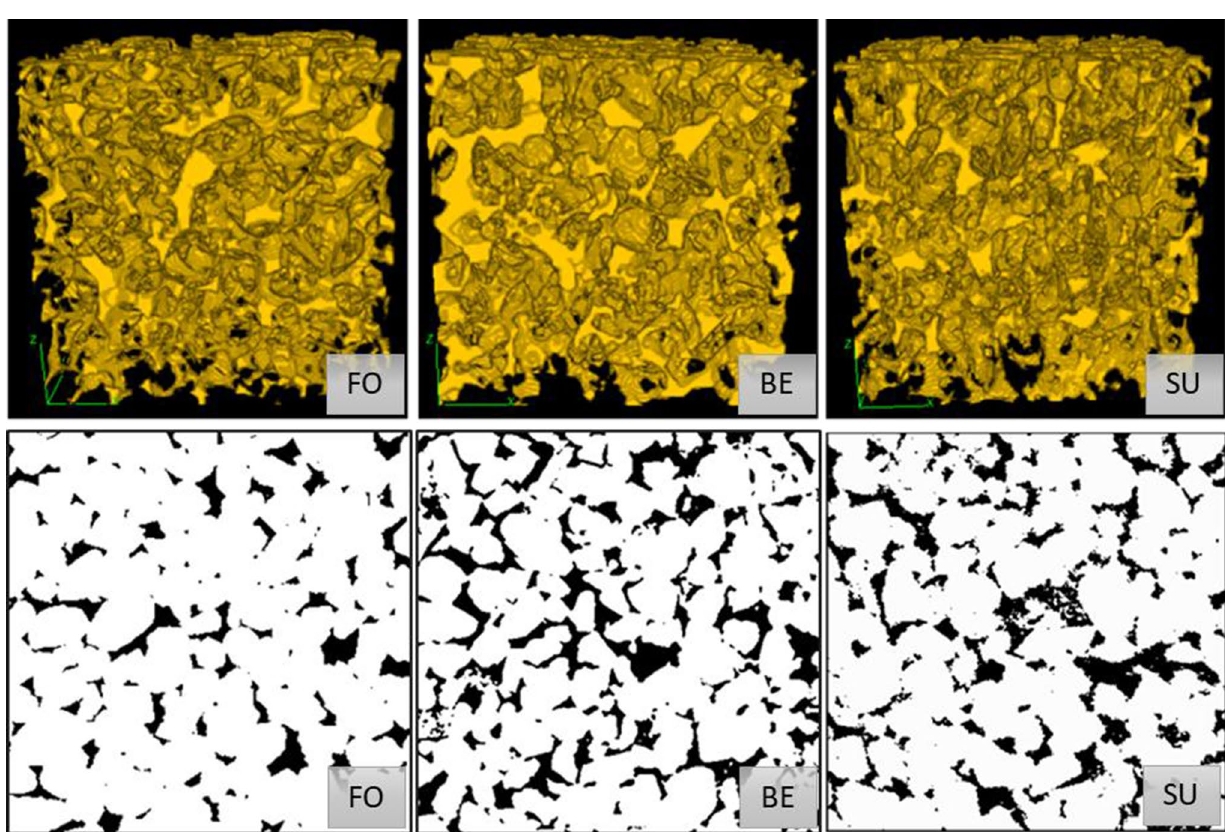
Fig. 4 3D visual (top) and 2D cross sections (bottom) of the samples. Left to right: Fontainebleau (FO), Berea (BE), and Sumatra (SU)